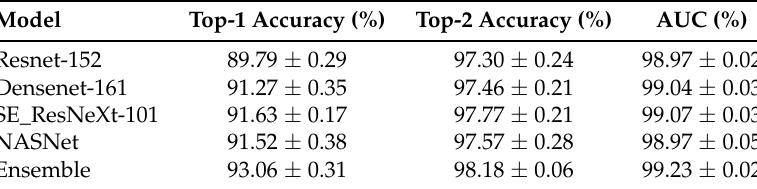
Table A3. Detailed results of 7-ary classification for individual classifiers and their ensemble on ISIC Archive-2018.